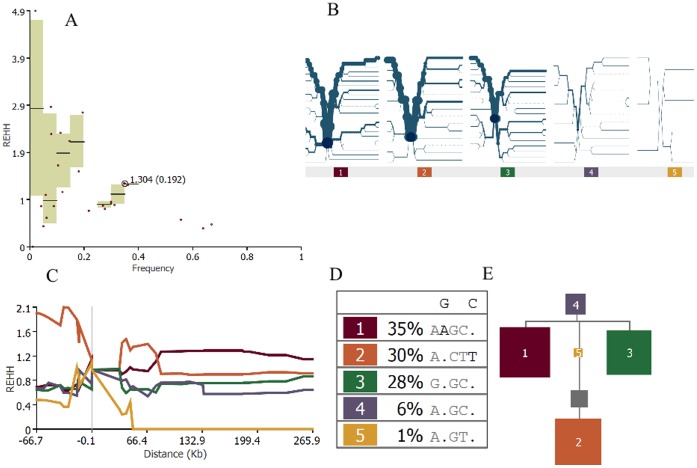
The analysis results based on the late age of first phrase (late-AFP) group are shown.Panel A shows the scatter plot of REHH plotted against all core haplotype frequency (circled dot indicates the selected core haplotype “rs1074014-rs1072877-rs1564582-rs11212724-rs11211725”). Panel B shows the haplotype bifurcation diagram, which visualizes the breakdown of LD at increasing distances from core haplotypes at the selected core region. The root of each diagram is a core haplotype, identified by a dark blue circle. Panel C illustrates how the REHH value varies by the selected core haplotype. Panel D shows the table of core haplotype, and the dot in the observed haplotype sequence represents the allele that matches the ancestral. Panel E presents the theoretical phylogenetic tree of different core haplotypes. Gray squares represent haplotypes that are not present in the observed data, but are missing links in the phylogeny. The area of the squares is proportional to the frequency of the haplotype.